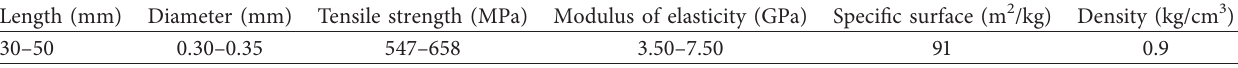
Table 1: Fiber properties.